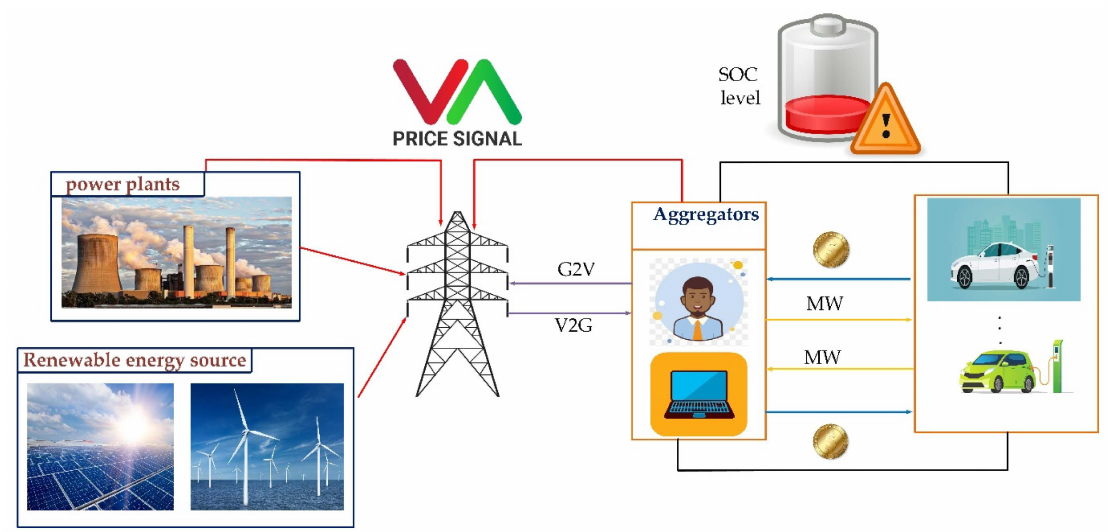
Figure 3. Examining the role of EV aggregators in smart